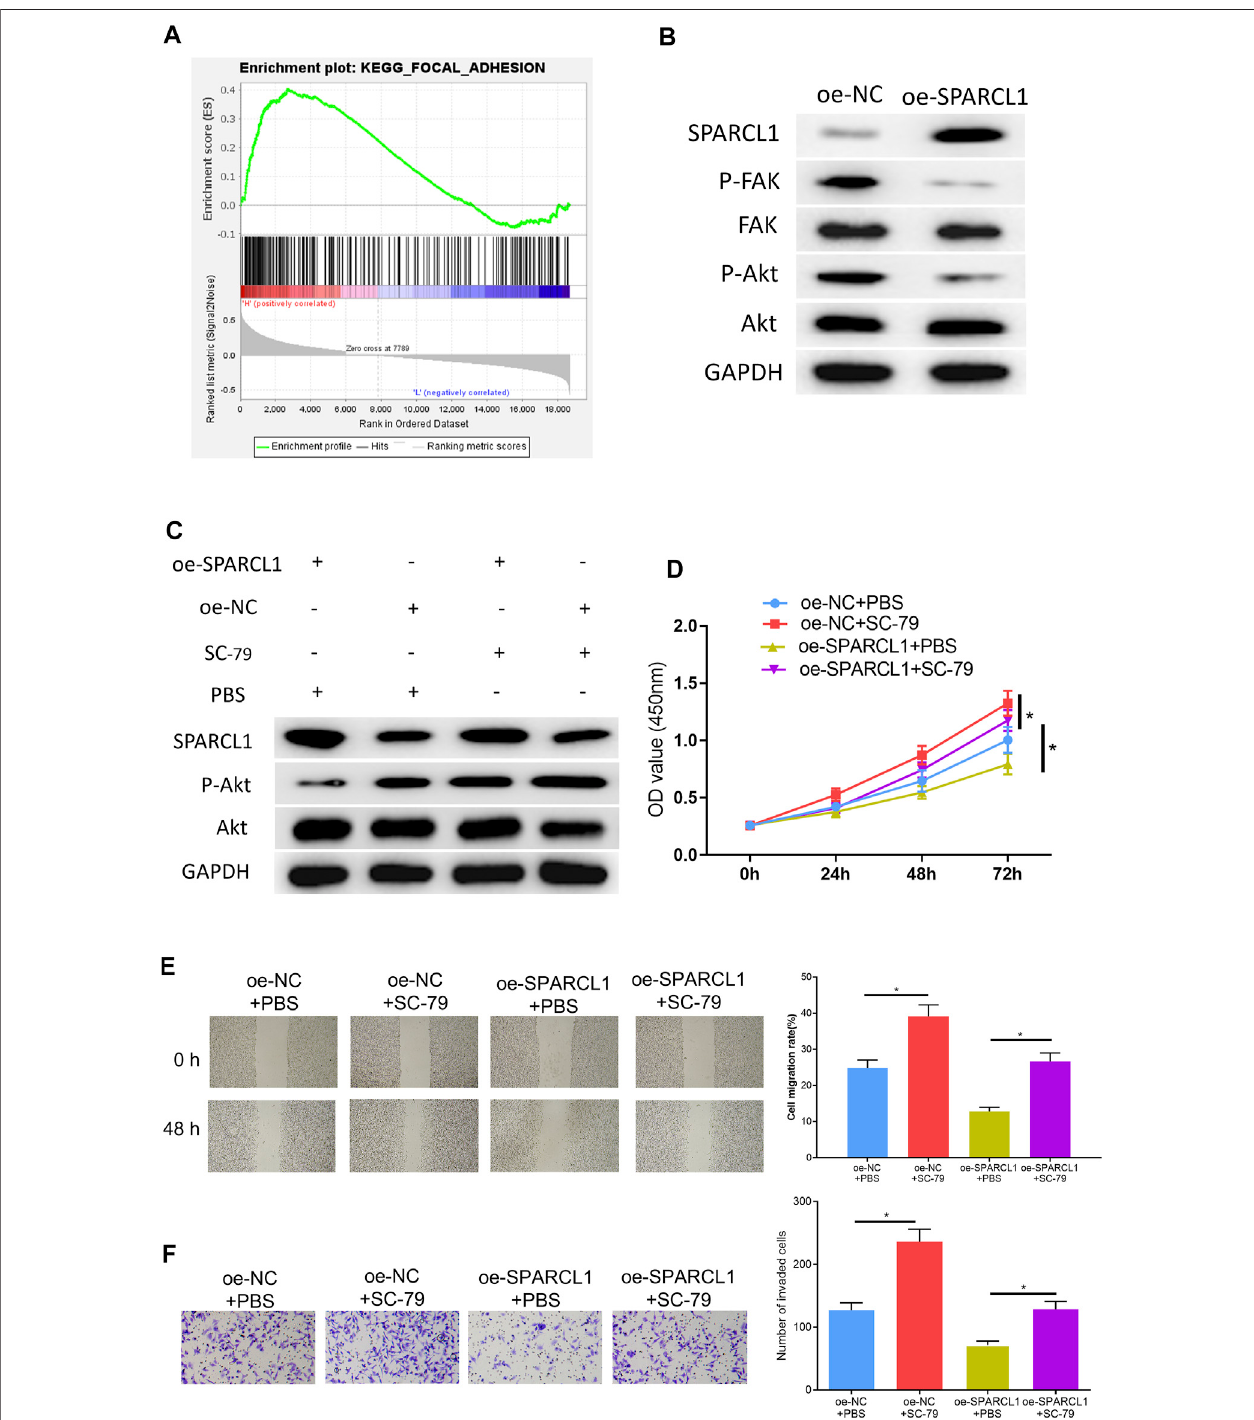
FIGURE5| SPARCL1inhibitsESCCcellprogressionbymodulatingFAK/Aktsignalingpathway. (A) GSEAresultofSPARCL1; (B) Theproteinexpressionlevelsof SPARCL1 and FAK/Akt signaling pathway-related proteins in ESCC cells upon SPARCL1 overexpression; (C) The protein expression levels of SPARCL1 and FAK/Akt signaling pathway-related proteins in ESCC cells with an addition of p -Akt activator SC-79; (D – F) CCK-8 assay (D), wound healing assay (40×), and (E) Transwell invasion assay (×100) (F) were carried out to evaluate whether SPARCL1 suppresses ESCC cell proliferation, migration, and invasion via FAK/Akt signaling pathway; * p <